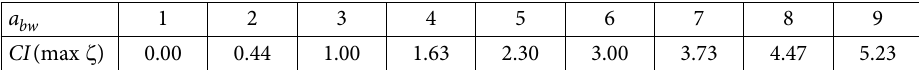
Table 3. The consistency index (CI) (source: Rezaei, 2015) a bw 1